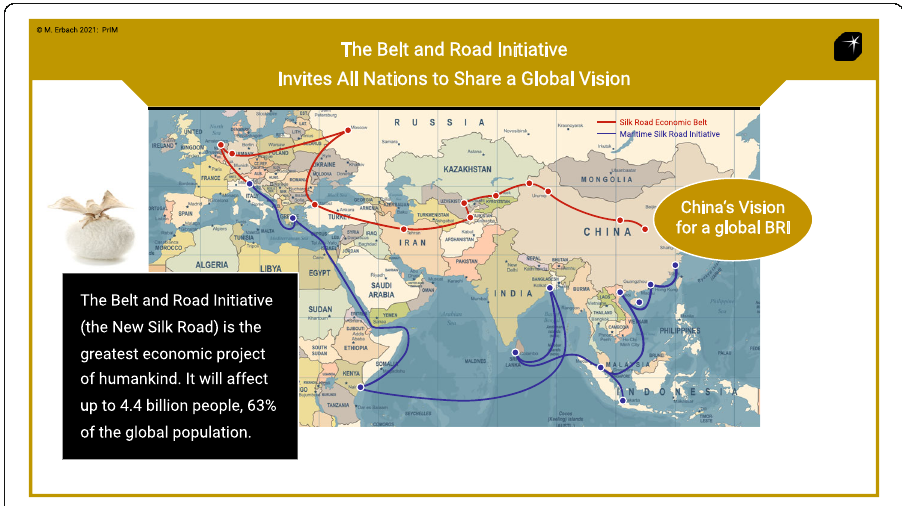
Fig. 1 The Chinese Belt and Road